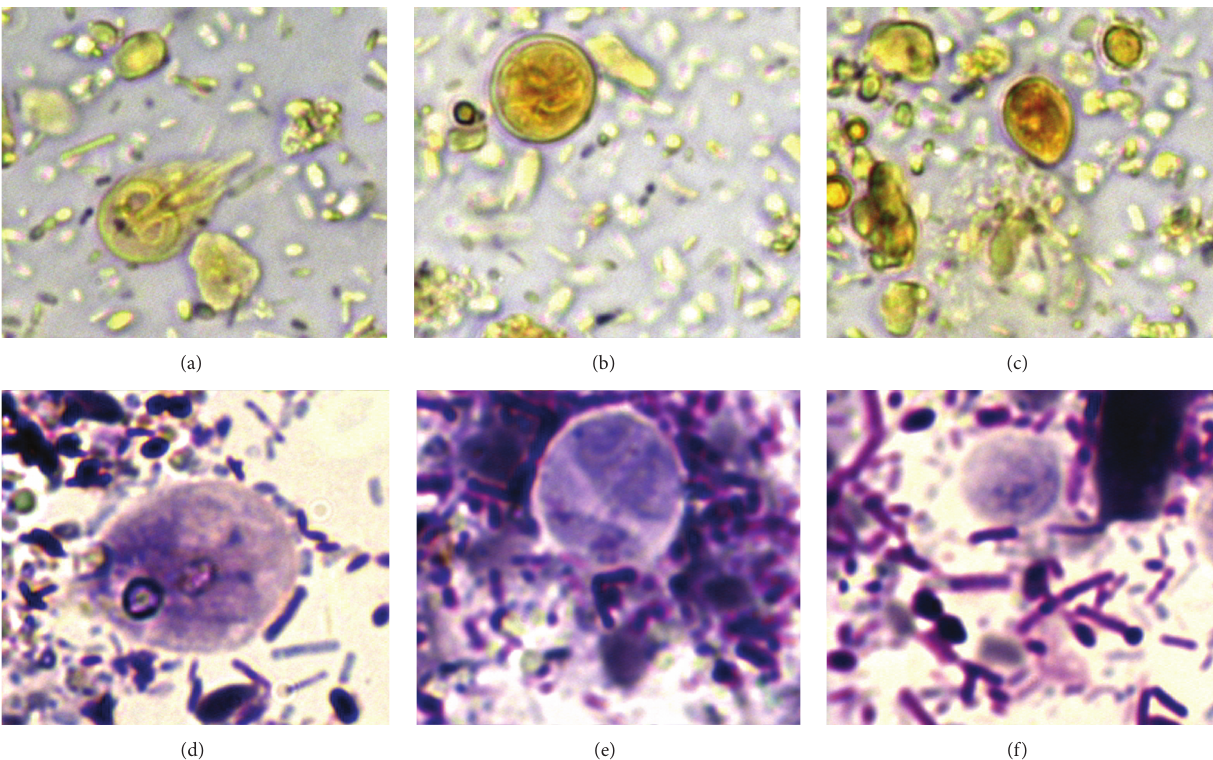
Figure 1: Fecal smears from a 6-month-old female Maine Coon cat with chronic liquid diarrhea stained with Lugol’s solution (a–c) and Giemsa stain (d–f); (a) and (d) showed Giardia duodenalis trophozoite; (b) and (e) showed a Giardia duodenalis cyst; (c) and (f) showed drop-shaped trichomonads (630x).